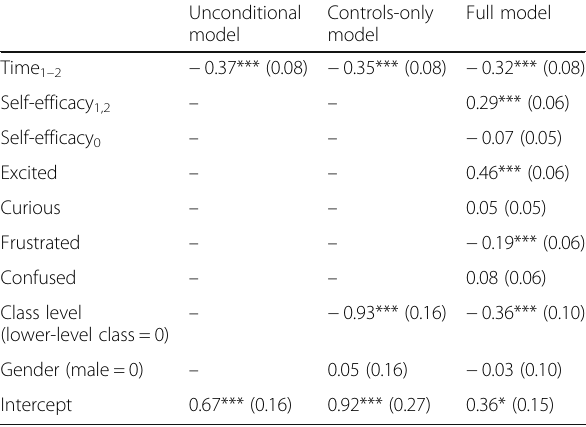
Table 6 Hierarchical linear growth model of